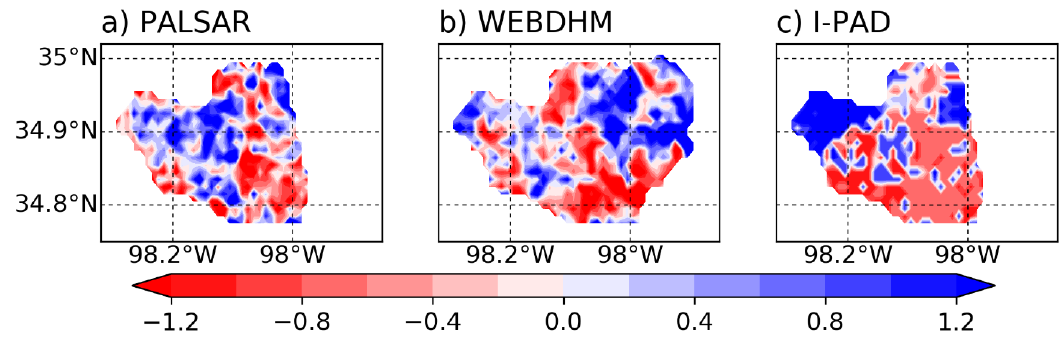
Figure 10. Spatial distributions of normalized surface soil moisture on 2 March 2007 obtained by ( a ) PALSAR ( b ) WEB-DHM, and ( c ) the I-PAD model after a month-long run.